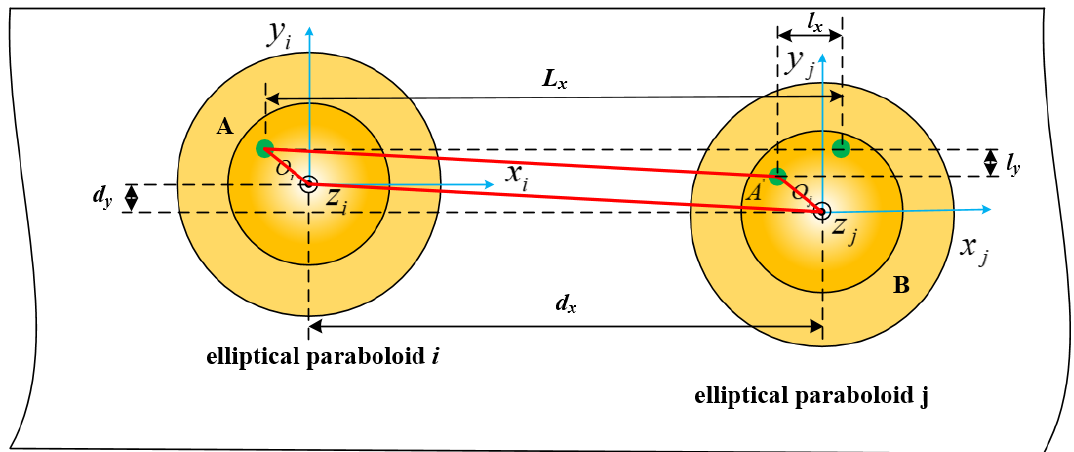
Figure 5. Calibration principle according to the geometric relationship.